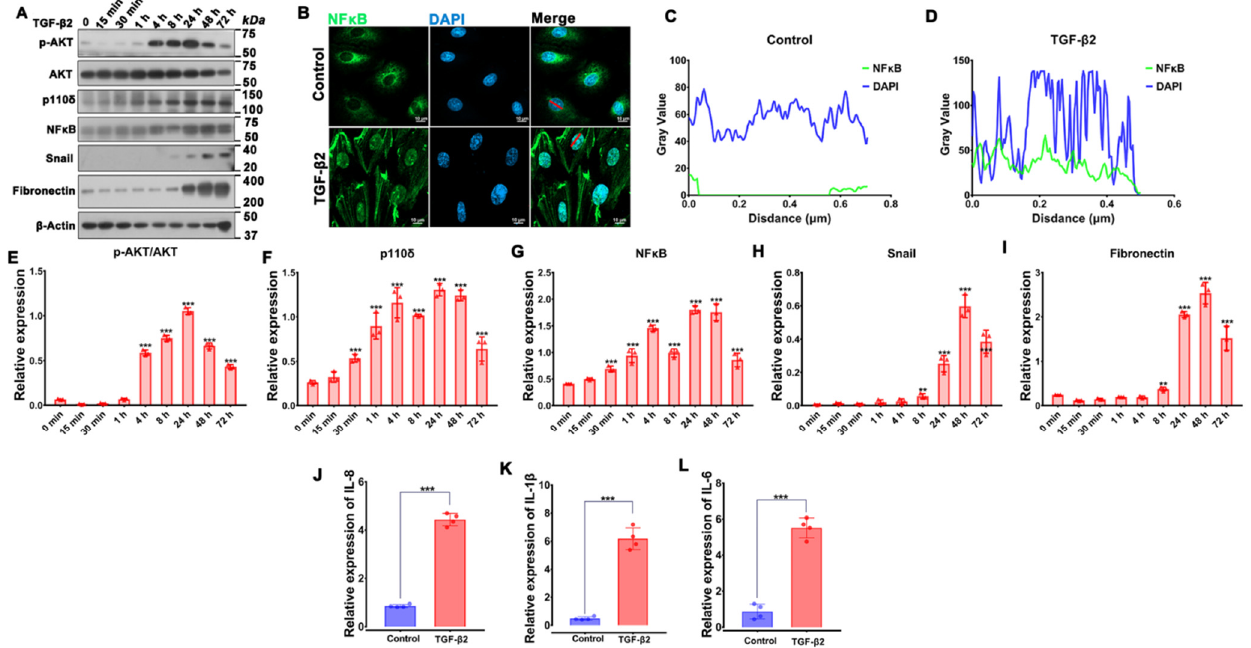
Figure 2. TGF- β 2-induced activation of Akt, expression of p110 δ , nuclear translocation of NF κ B/p65 as well as EMT. ( A ). ARPE-19 cells were treated with TGF- β 2 (10 ng/mL) for the indicated time points, followed by immunoblotting analyses. ( B ). ARPE-19 cells treated with TGF- β 2 (10 ng/mL) for 48 h were immunofluorescence stained with antibodies to NF κ B/p65 (green). Blue: DAPI. Red line: the location of the co-localization. Scale bar: 10 μ m. ( C,D ). Co-localization analysis of NF κ B with nucleus was performed by Image J [40]. ( E – I ). Quantitation of Western blotting band intensity in A. The graphs are mean ± standard deviation (SD) of three independent experiments. ** p < 0.01, *** p < 0.001. ( J – L ). mRNA from ARPE-19 cells treated with TGF- β 2 (10 ng/mL) for 48 h was extracted and subjected to reverse qPCR. The graphs are mean ± SD of 4 independent experiments. The data were analyzed using one-way ANOVA followed by the Tukey HSD post hoc test. ** p < 0.01, *** p < 0.001.